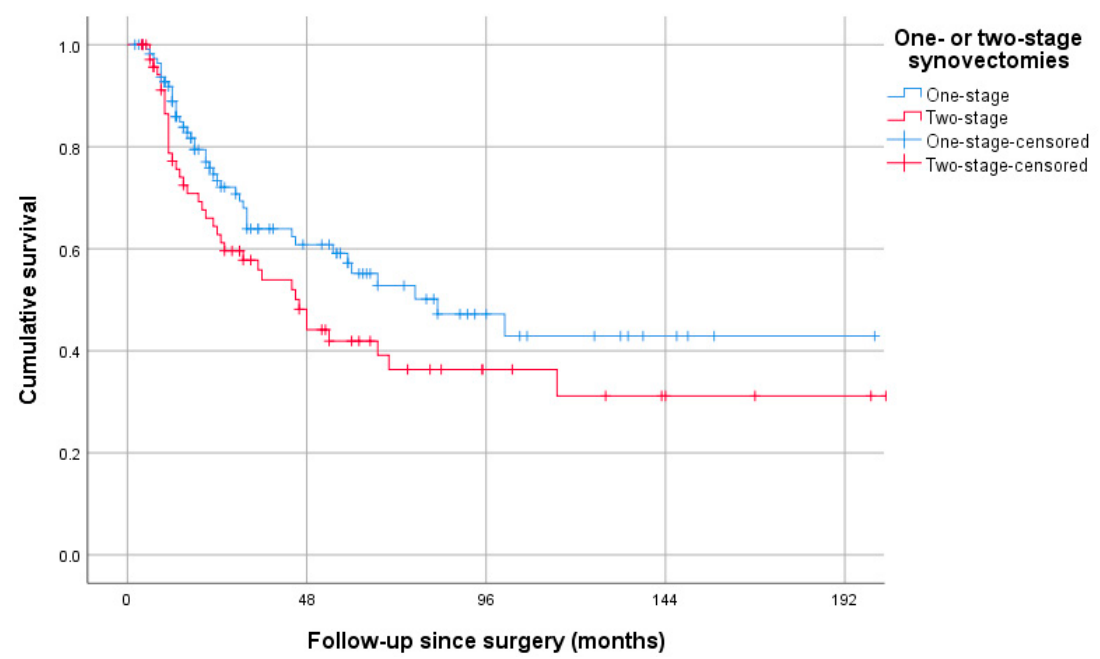
Figure 3. Postoperative progression-free survival; Kaplan–Meier analysis.